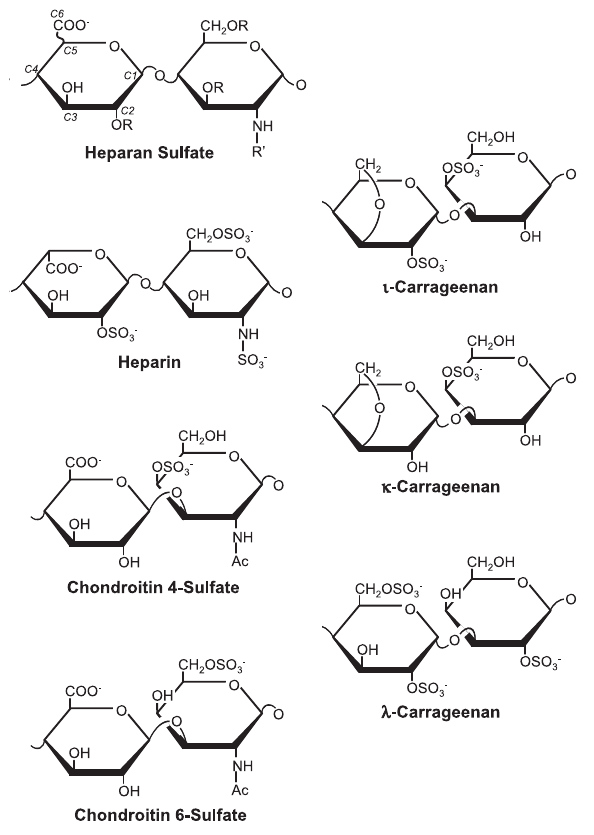
Figure 1. Polysaccharide Structures Idealized average structures of the disaccharide repeat units of various sulfated polysaccharides. Ac ¼ acetyl, R ¼ [H or SO 3 (cid:3) ], R 9 ¼ [H, Ac, or SO 3 (cid:3) ]. Structures adapted from [13], http://www.lsbu.ac.uk/water/hycar. html, and http://www.sigmaaldrich.com.